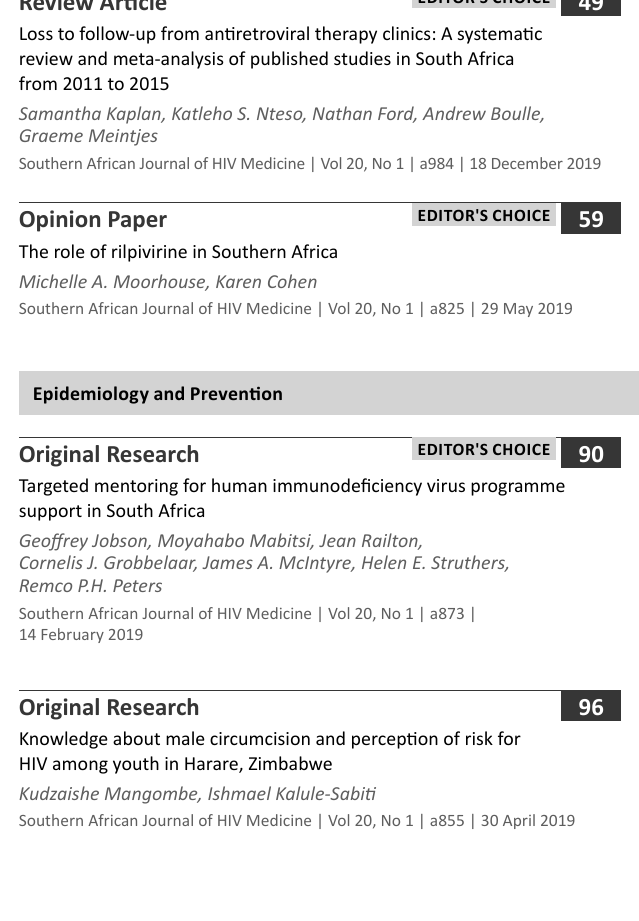
An unusual case of abdominal mycobacterial infection: Case report and literature